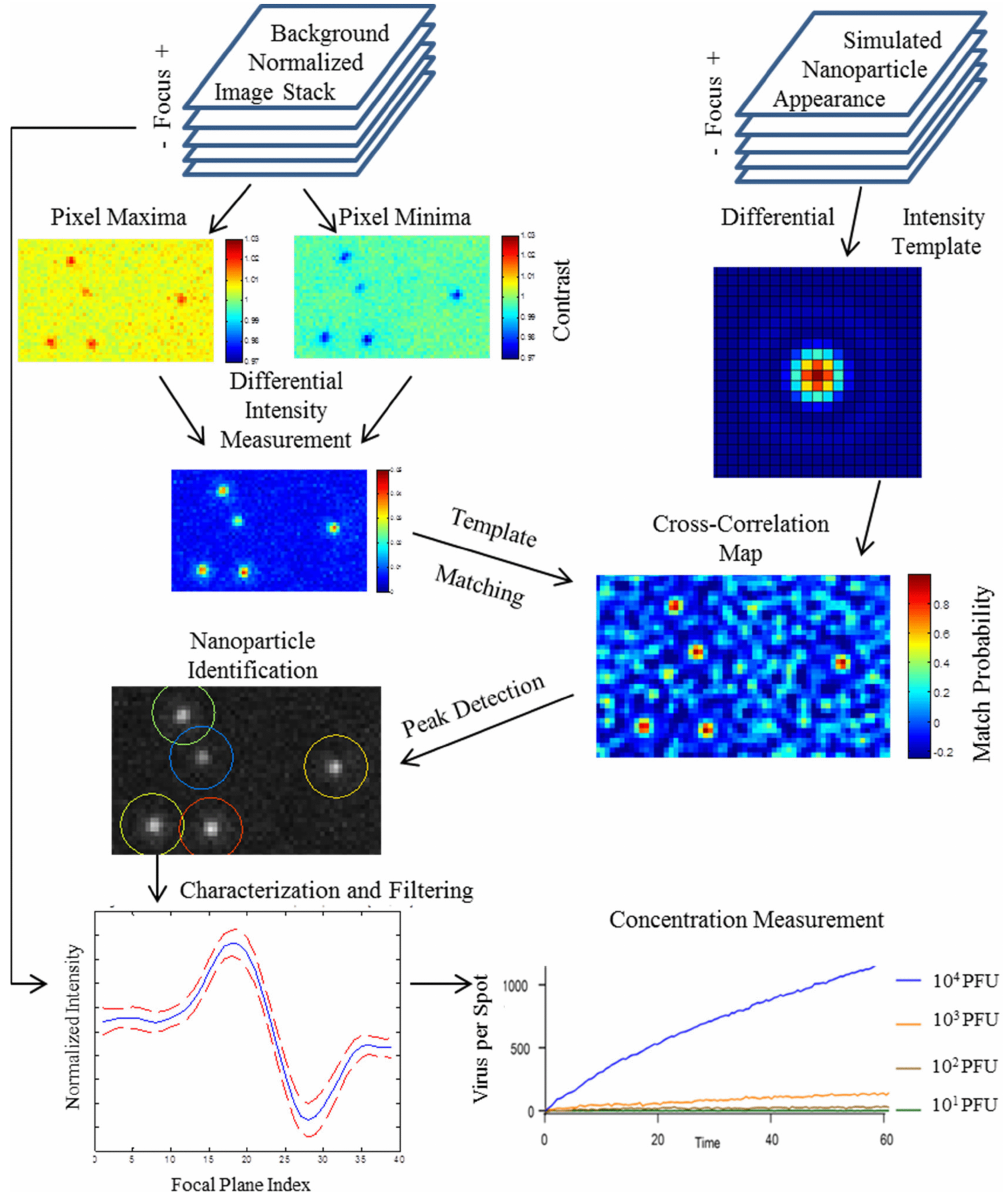
Figure 3. Block diagram of algorithm for nanoparticle detection and counting using z-stacks of incrementally defocused images. Adapted with permission from Ref.